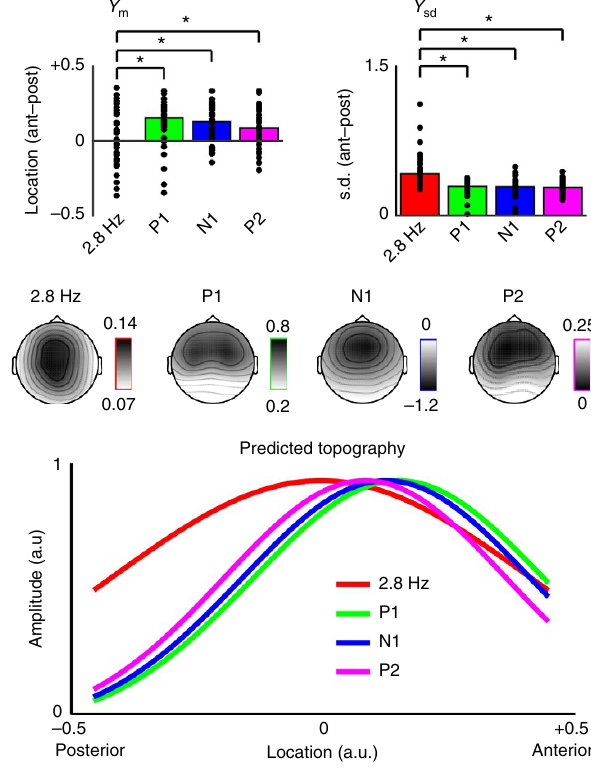
Figure 4 | Topographies differ for entrained neural responses (2.8Hz) and ERPs. Actual topographies for each neural response type are shown in the centre of the plot (arranged horizontally, 2.8Hz, P1, N1 and P2, responses; note that for this analysis the N1 topography was sign-inverted). Bar graphs (top) summarize the median (bar) and single-participant (black dots) data for each type of neural response and each fitted Gaussian parameter ( y m on left and y sd on right). Note: two outliers are not shown for the 2.8Hz condition for parameter y sd (values were 8.15 and 40.24). Line plot (bottom) shows predicted topographies for each neural response type in the anterior-posterior plane (right) based on median parameter values over participants. Entrained-response topographies were dissociable from ERP-component